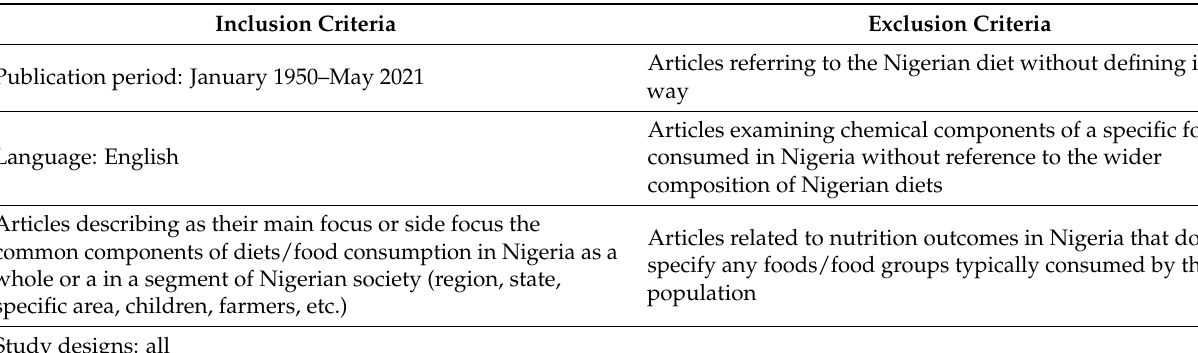
Table 1. Inclusion and exclusion